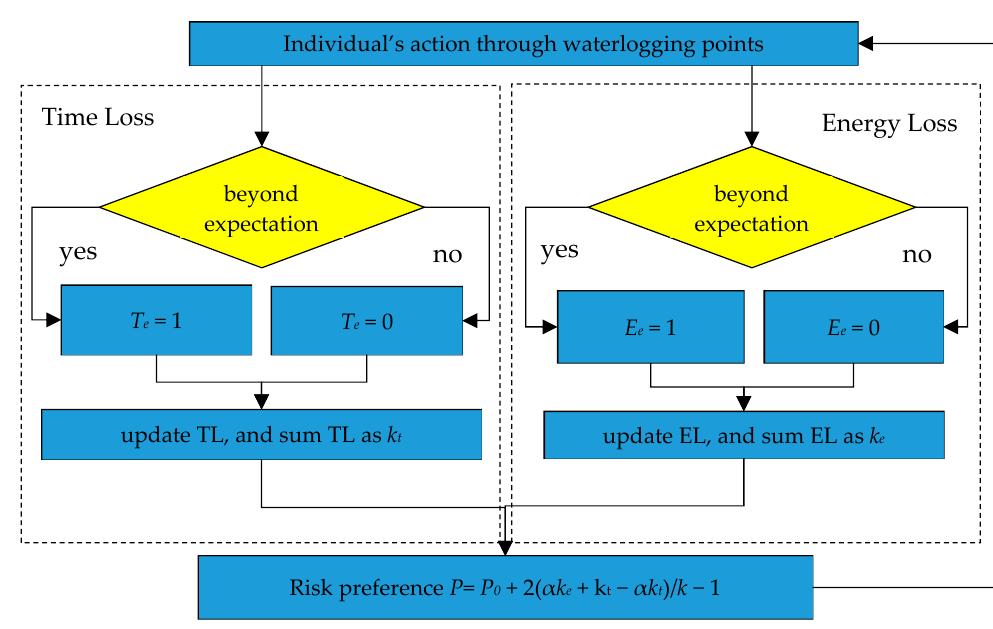
Figure 5. Agent’s decision rule during the escaping in the rainstorm.